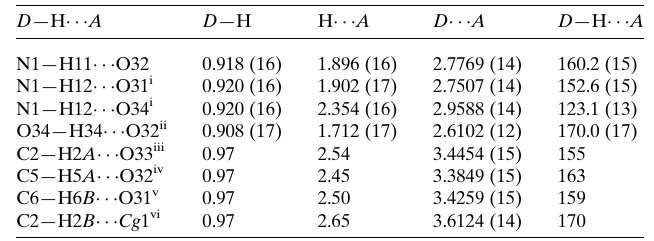
Table 2 Hydrogen-bond geometry (A˚ , (cid:4) ) for (II).